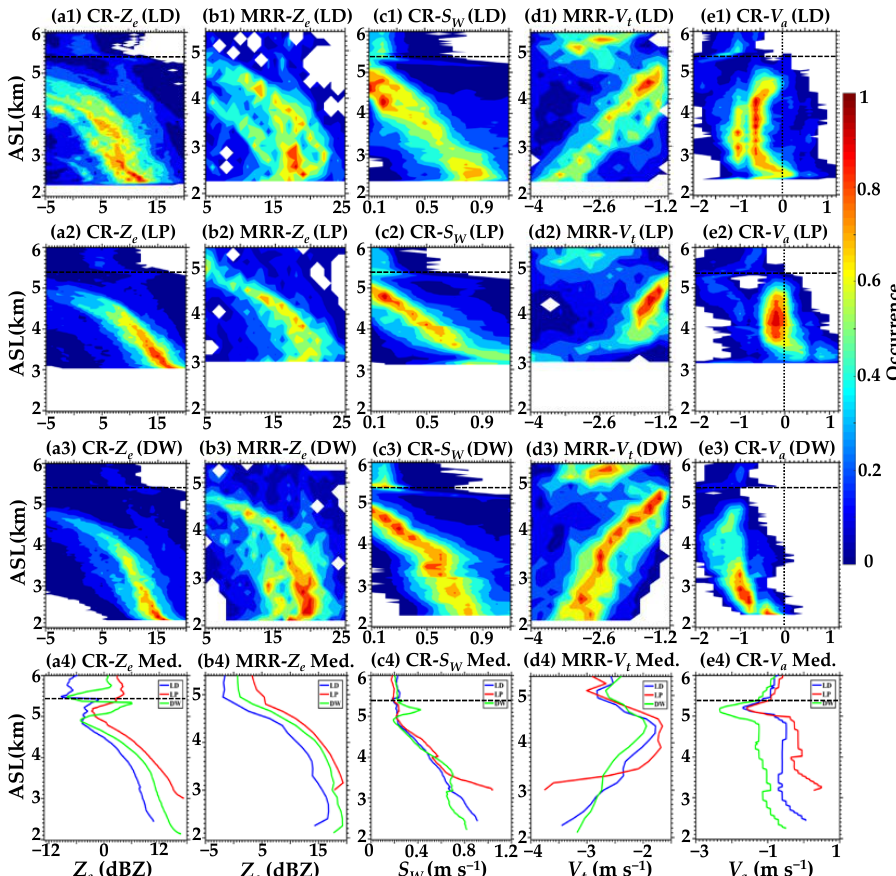
Figure 9. Normalized contoured frequency by altitude diagrams (NCFADs) of equivalent reflectivity factor ( Z e , dBZ), spectrum width ( S W , m s −1 ) and vertical air velocity ( V a , m s −1 ) measured by the CR, and Z e (dBZ) and particle falling velocity ( V t , m s −1 ) measured by the MRR for the stratiform cloud and precipitation stage. Subfigures ( a1 – e1 ), ( a2 – e2 ) and ( a3 – e3 ) represent the results at the LD, LP, and DW sites, respectively, and ( a4 – e4 ) denote median profiles (Med.) of radar variables. The black dotted line represents the 0 °C isotherm (horizontal) at about 5.4 km, ASL, and 0 m s −1 isoline (vertical).